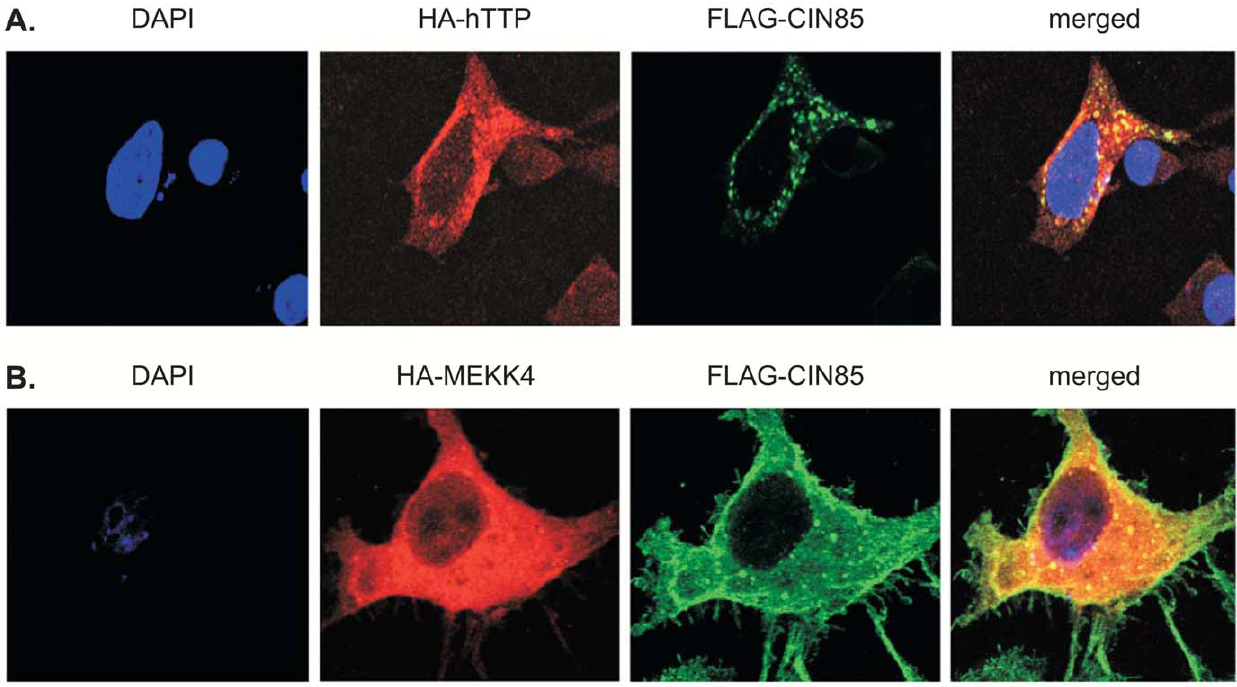
Figure 5. Localization of hTTP and MEKK4 with CIN85 in cultured cells. In A, HEK 293 cells were transfected with plasmids for the expression of HA-hTTP (red) and Flag-CIN85 (Green), or (B) HA-MEKK4 (red) and Flag-CIN85 (green). The cells were stained with primary antibodies, either an anti- HA polyclonal or anti-Flag monoclonal, followed by the secondary antibodies Alexa 594 anti-rabbit (red) or Alexa 488 anti-mouse (green), respectively. Nuclei (blue) were stained with DAPI. The cells were visualized and images obtained by confocal microscopy. The merged images of two protein signals, indicating areas of apparent co-localization, are shown in yellow.